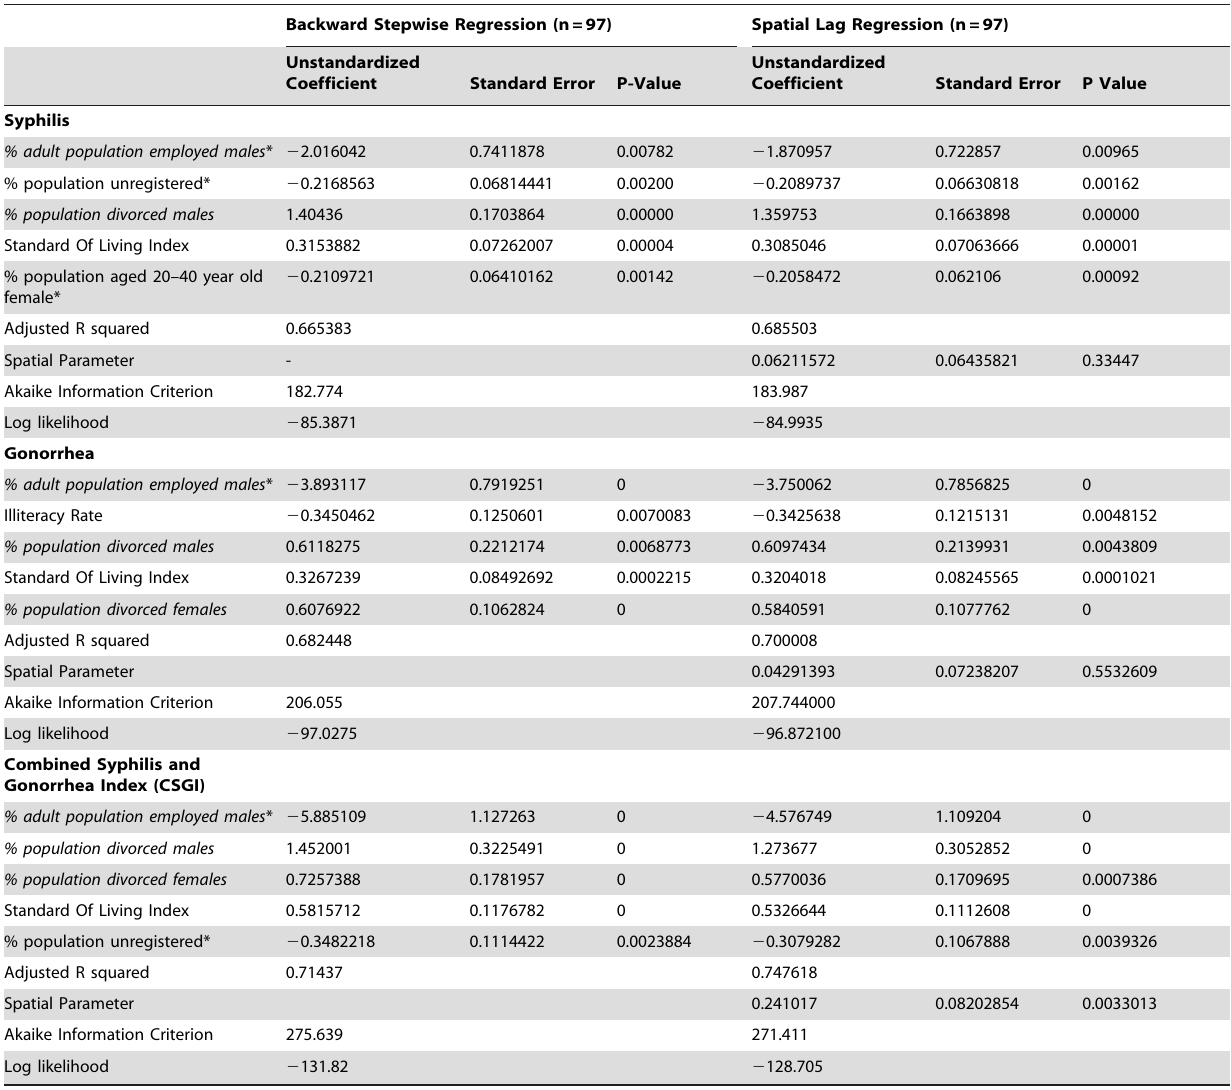
Table 3. Backward Stepwise Regression and Spatial Lag Regression